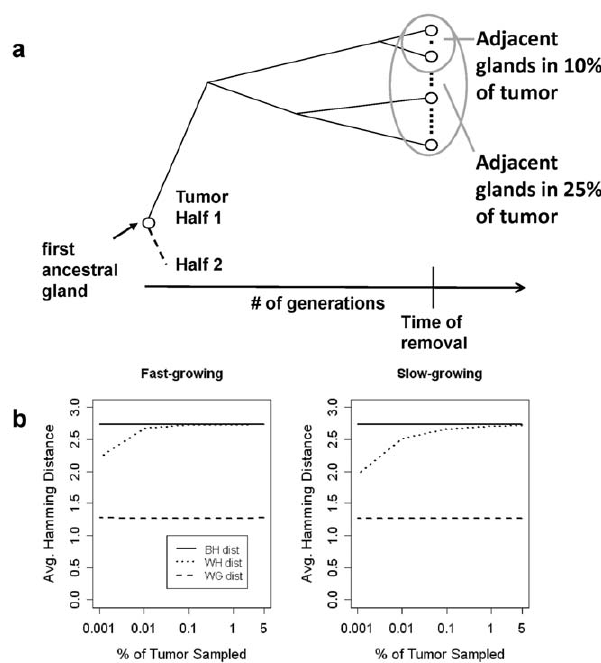
Figure 5. The relationship between physical proximity in the tumor and epigenetic distance. (a) The relationship between the fraction of tumor sampled and time to the most recent common ancestor. (b) Mean estimates of average Hamming distance for three physical distances: between tumor half (BH), within tumor half (WH) and within gland (WG) under different growth curve inflection times (inflection time is 49 for figure on left and 320 for figure on right) (N=10,000 replicates).